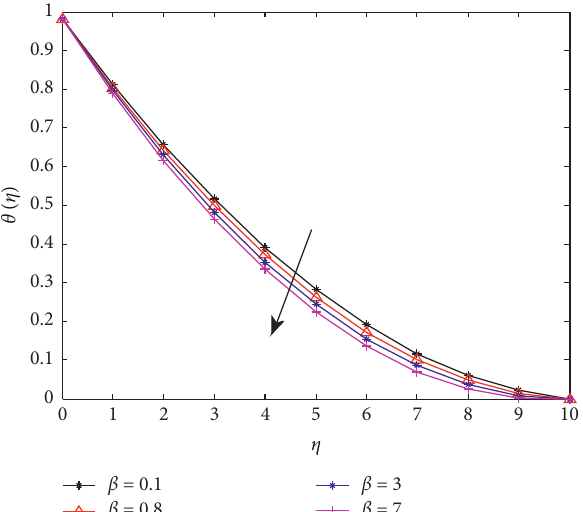
Figure 10: Temperature alteration for numerous values of β when Pr � 0 . 72, c � 0 . 2, Ω � M � λ � R � s � 1, c � 0 . 2, and Ec � 0 . 1.